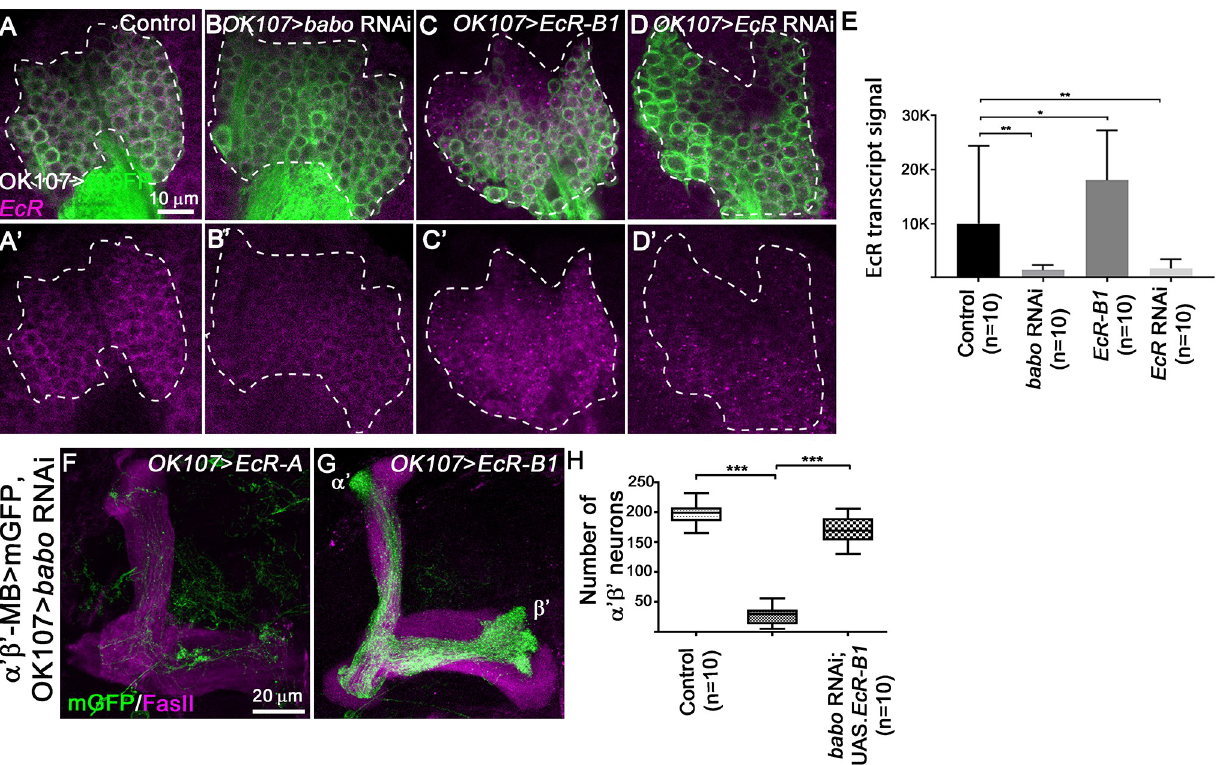
Fig 3. EcR-B1 isoform mediates TGF- β signalling-dependent α ’ β ’ MB neuron specification. (A-D’) WL3 MB cell bodies from control (A), OK107 > babo RNAi (B), OK107 > EcR-B1 (C) and OK107 > EcR RNAi (D) brains stained with anti- EcR RNA probe (magenta). Green: GAL4- OK107 - driven mGFP (A-D). (E) Quantification of EcR signal in control, OK107 > babo RNAi, OK107 > EcR-B1 and OK107 > EcR RNAi brains. 10 brains were analysed for each condition. Statistical comparison to the control: � , p < 0.05; �� , p < 0.01 (Mann-Whitney test). (F,G) Adult MB lobes from OK107 > babo RNAi, EcR-A (F) and OK107 > babo RNAi, EcR-B1 (G) brains stained with anti-FasII antibody (magenta). Green: GMR26E01 - LexA- α ’ β ’ - MB-driven mGFP in F,G. (H) Quantification of number of adult α ’ β ’ MB neuron cell bodies from control, OK107 > babo RNAi, EcR-A and OK107 > babo RNAi, EcR-B1 brains. Statistical comparison to the control or to OK107 > babo RNAi, EcR-A conditions: ��� , p < 0.001 (two tailed t test).